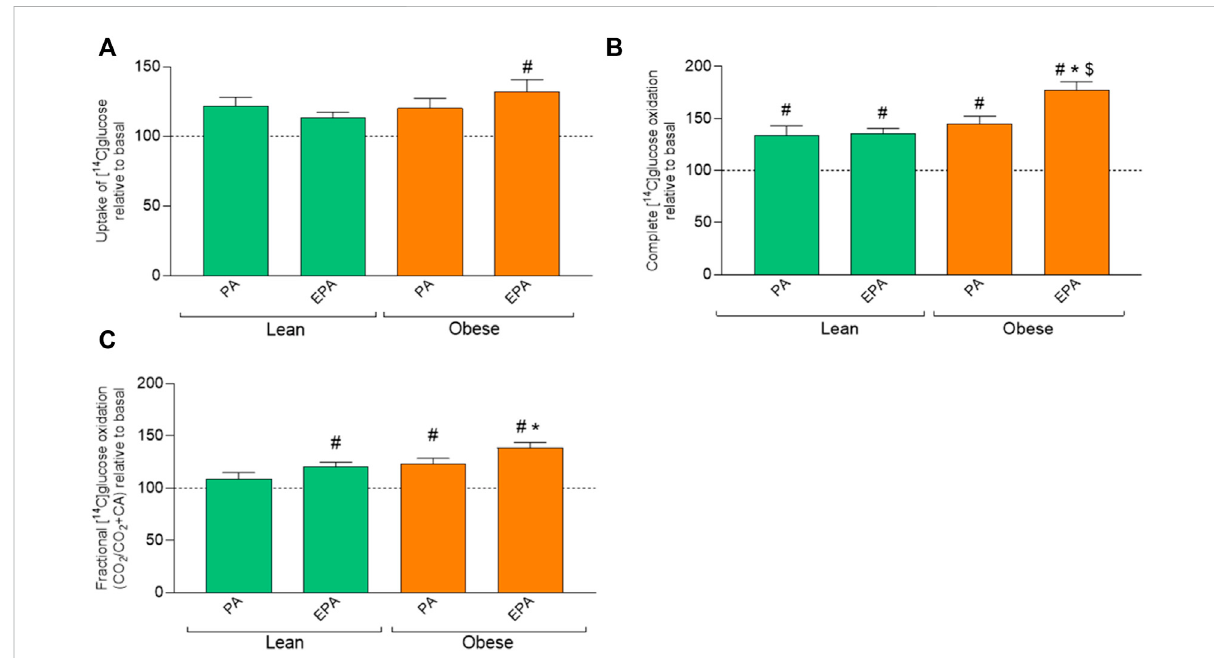
FIGURE 4 Effects of pretreatment with fatty acids on glucose metabolism in myotubes from lean and donors with obesity. Differentiated skeletal muscle cells (myotubes) from lean or donors with obesity were pretreated with either no fatty acid (basal), PA (100 µM) or EPA (100 µM) for 24 h, and then incubated with [ 14 C]glucose (200 µM) for 4 h. The fi gures show: (A) totaluptakeofglucosebythe cells (CO 2 +CA), (B) completeoxidationof glucose to carbon dioxide (CO 2 ), (C) fractional glucose oxidation (CO 2 /uptake). Results present means ± SEM ( n = 8). Results for lean group, basal (without treatment) was set to 100%, and for obese group, basal (without treatment) was set to 100%. Statistical signi fi cance was calculated as the difference between thetwo groups usingone way ANOVA, and these differenceswereconsidered signi fi cantif # p ≤ 0.05 vs.basal fromsame group, * p ≤ 0.05 vs. respective treatment for lean group and $ p ≤ 0.05 vs. PA from the same